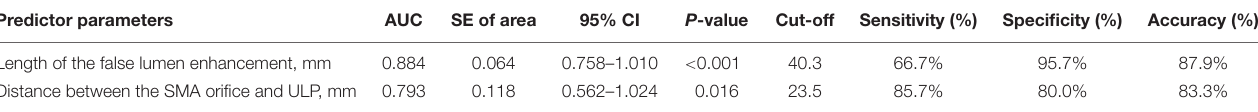
TABLE 5 | ROC analysis of the predictor CT parameters determining the dissection progression in Type II SISMAD with “cul-de-sac” shaped FL without re-entry and type change in Type III SISMAD with thrombosed FL with ULP. Predictor parameters